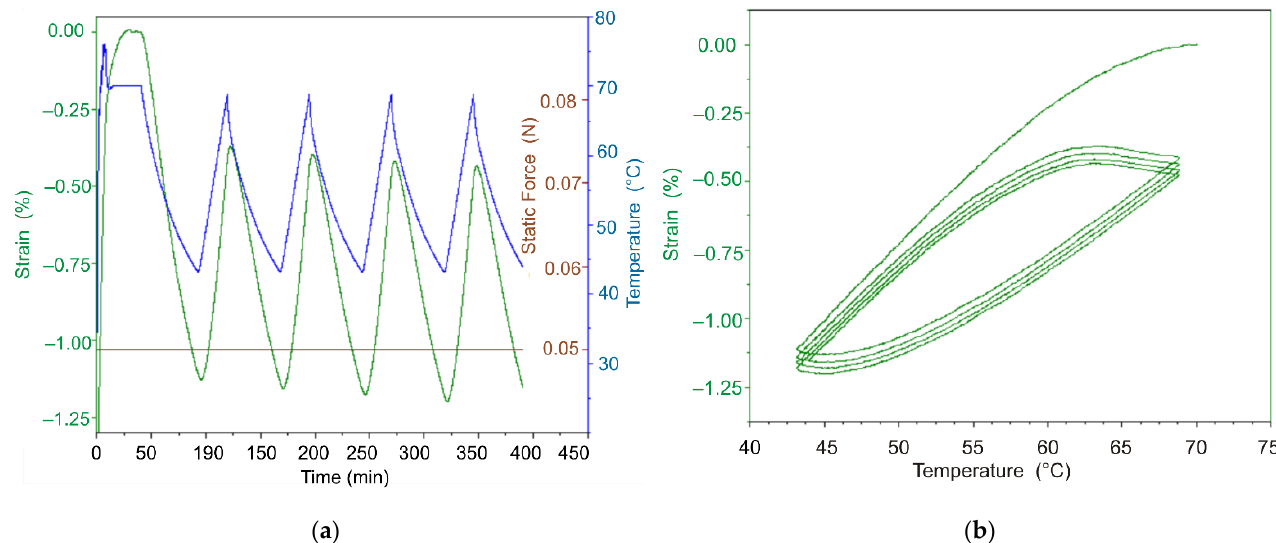
Figure 8. Evolution of temperature strain of the cylindrical sample under thermocycling conditions ( a ) and strain-temperature diagram ( b ). Thermal expansion of the cylindrical specimen under the controlled force of 0.05 N, cyclically varying temperature in the range 43–68 ◦ C, at a heating rate of 2 ◦ C/min, and with natural cooling. The strain is counted from 40 min, corresponding to the beginning of the thermocycling and temperature 70 ◦